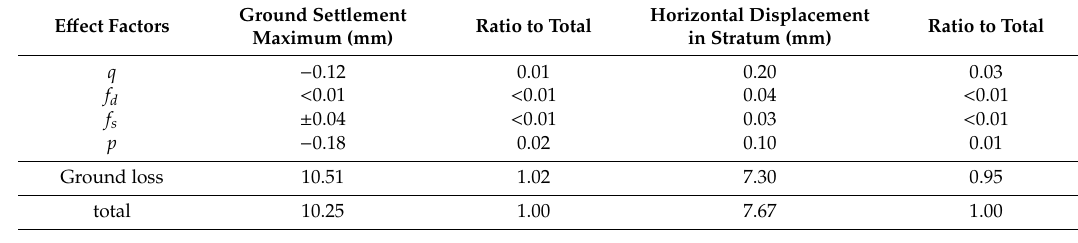
Figure 16. Ground uplift of different p .